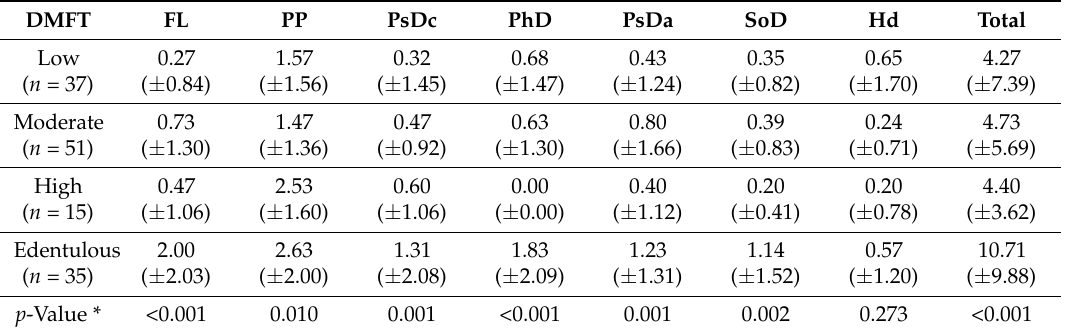
Table 5. Association between the DMFT categories and the mean domain and total scores (mean ( ± SD)) for the